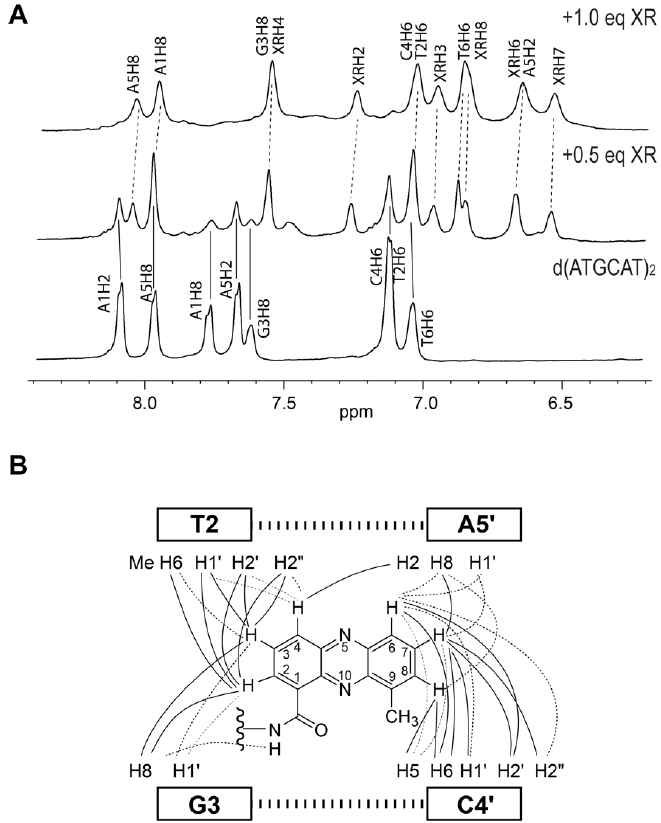
Figure 3. ( A ) The aromatic proton region of 1D 1 H NMR titration of XR5944 to dsDNA d(ATGCAT) 2 . Titration of XR5944 diminishes the peaks of the free DNA (labeled by solid lines), accompanied by the emergence of a new set of well-resolved peaks of the drug–DNA complex (dashed lines). ( B )